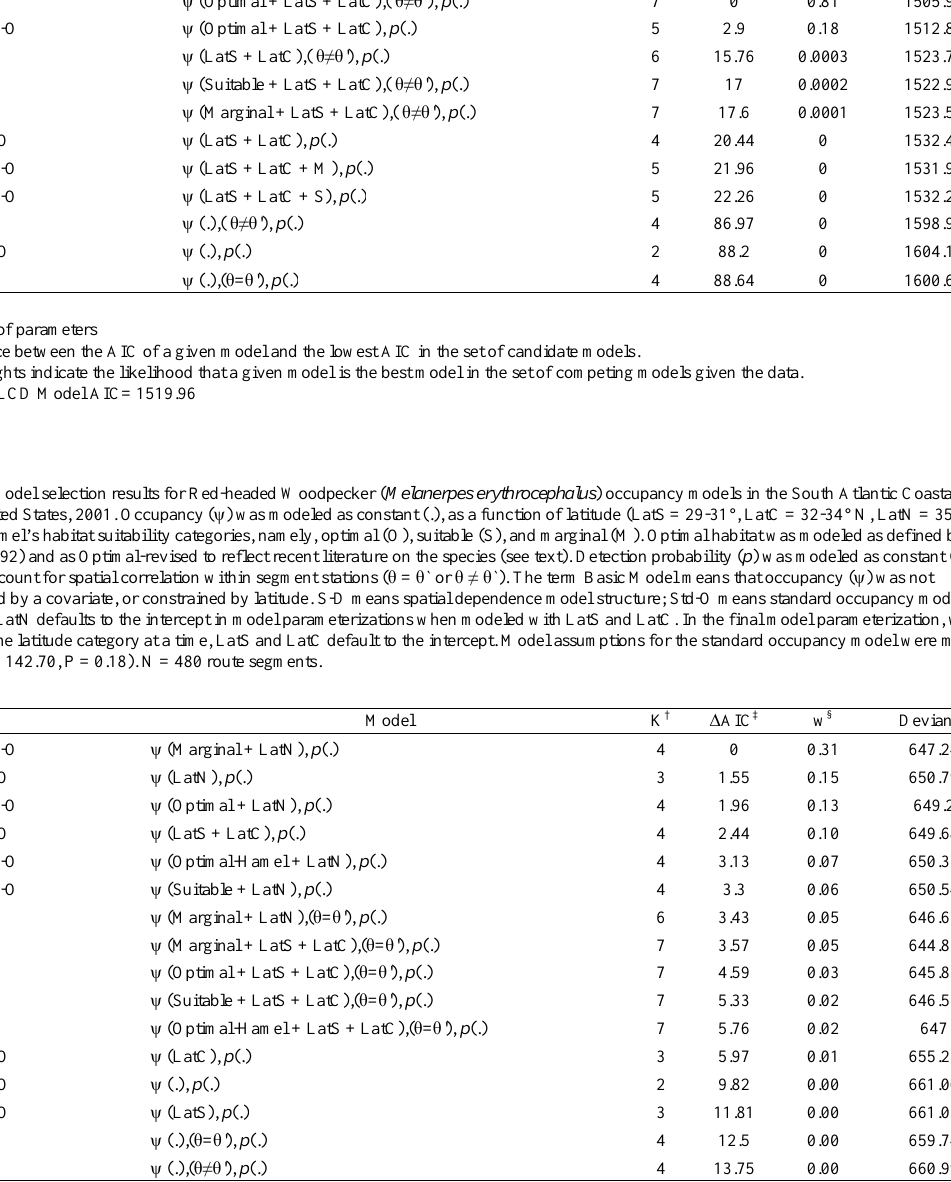
Table 4. Model selection results for Eastern Wood-Pewee ( Contopus virens ) occupancy models in the South Atlantic Coastal Plain, United States, 2001. Occupancy ( ψ ) was modeled as constant (.), as a function of latitude (LatS = 29-31°, LatC = 32-34° N, LatN = 35-37° N) and Hamel’s habitat suitability categories, namely, optimal (O), suitable (S), and marginal (M). Detection probability ( p ) was modeled as constant (.). Models account for spatial correlation within segment stations ( θ = θ ` or θ ≠ θ `). The term Basic Model means that occupancy ( ψ ) was not constrained by a covariate, or constrained by latitude. S-D means spatial dependence model structure; Std-O means standard occupancy model structure. LatN defaults to the intercept in the model parameterization. N = 480 route segments. Model Set